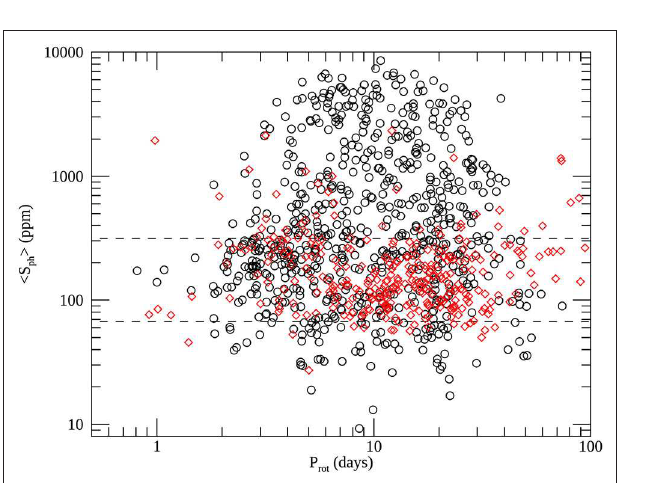
FIGURE 8 | Distribution of the < S ph > for the non-oscillating stars selected as in bottom panel of Figure 4 with the same color code. The dash lines in each panel correspond to the magnetic activity distribution of the oscillating stars in each spectral type.